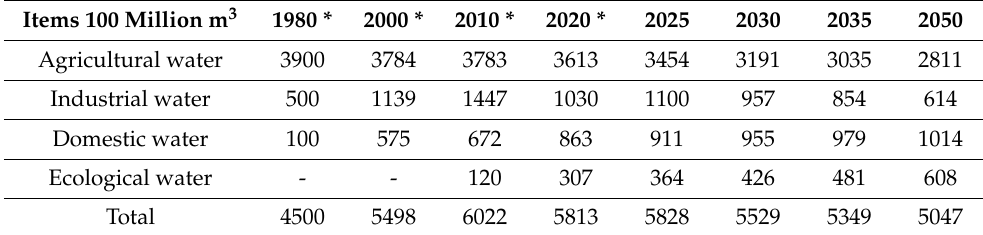
Table 3. Water resources consumption/demand in China from 1980 to 2050.